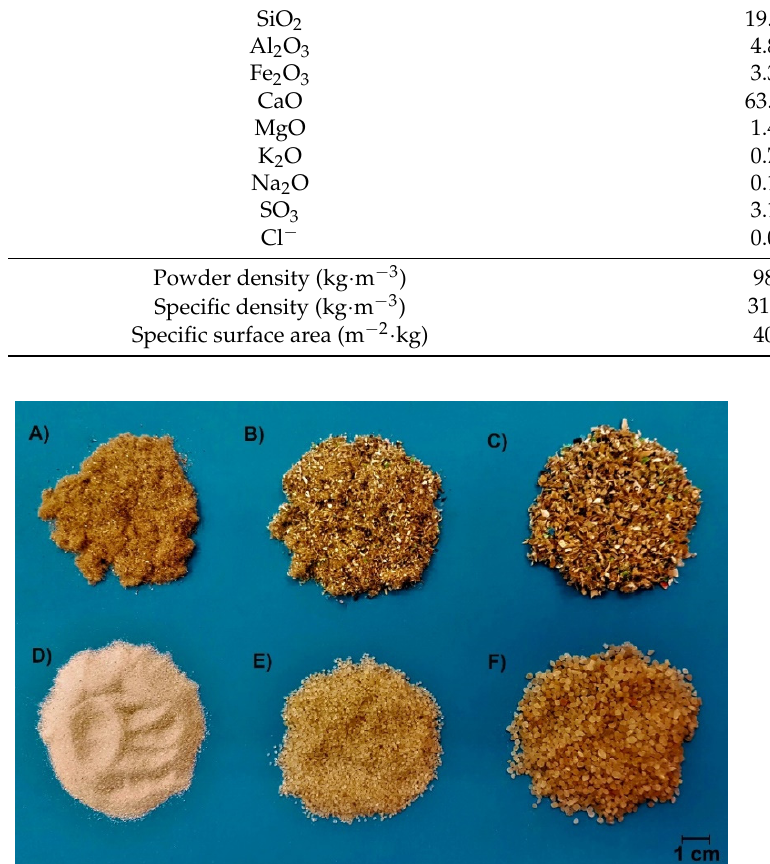
Figure 1. Samples of silica sand (SA) and waste aggregate (LA) separated into individual fractions; ( A ) LA (0.0/0.5 mm), ( B ) LA (0.5/1.0 mm), ( C ) LA (1.0/2.0 mm), ( D ) SA (0.0/0.5 mm), ( E ) SA (0.5/1.0 mm), ( F ) SA (1.0/2.0 mm).